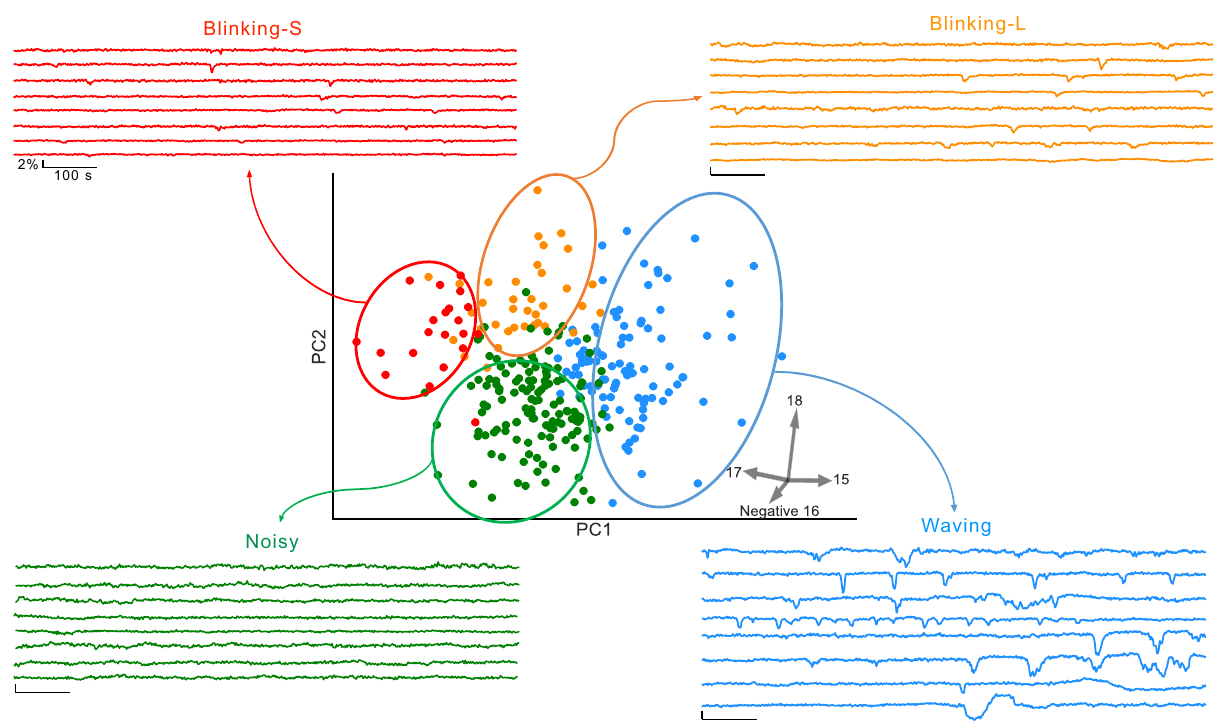
Fig. 5 Exemplar time series for each DES class. Representative time series were selected by sorting the values of the feature ’ s pointing in the direction of each type in 2D PC